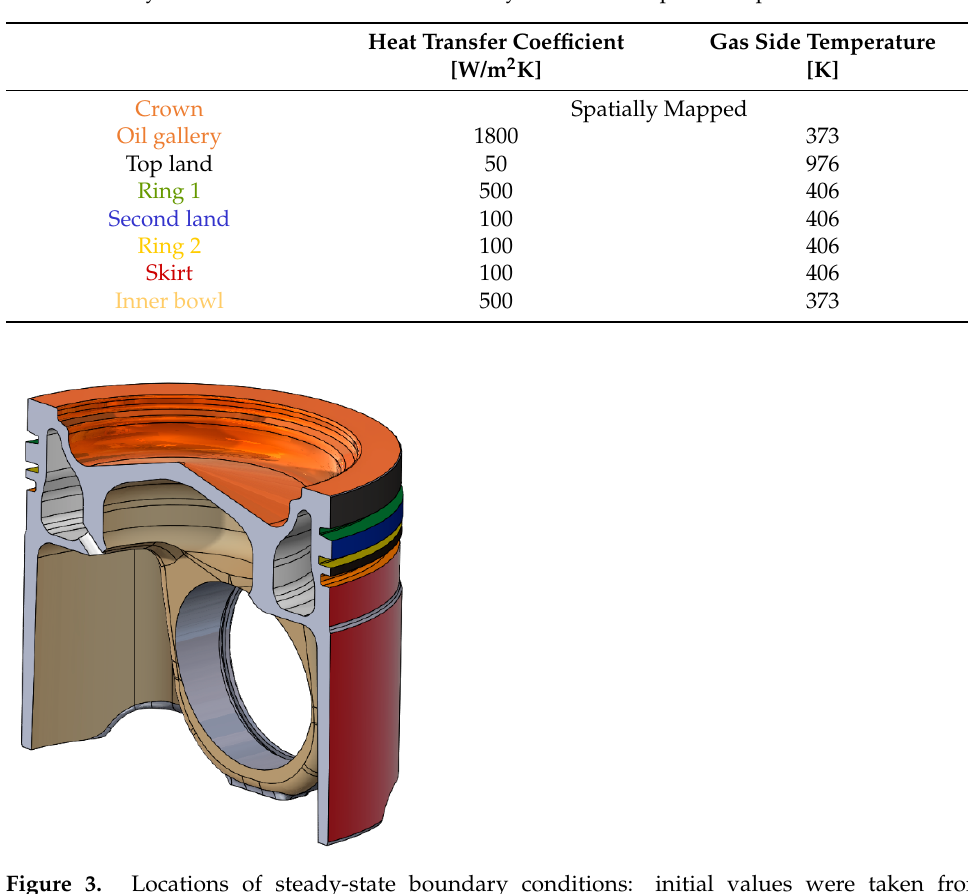
Table 3. Steady-state convective heat flux boundary conditions imposed on piston.